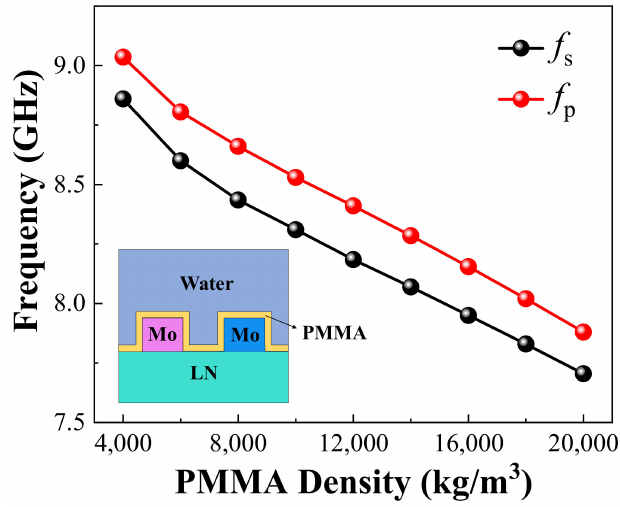
Figure 5. Variation of f s and f p with different PMMA densities. The inset is the structural design of biosensor based on HF-LWR.